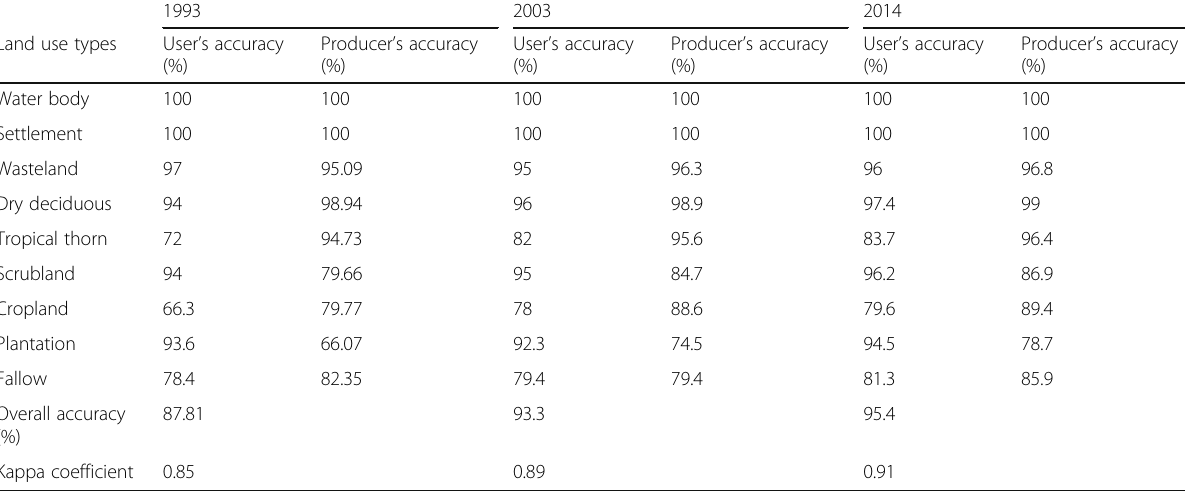
Table 5 Accuracy assessment of classified map of 3